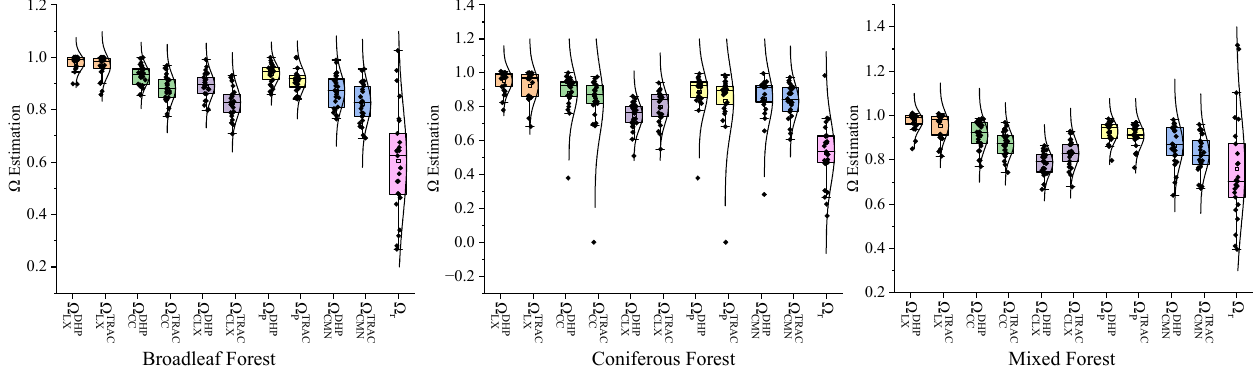
Figure 5. A comparison of CI estimation values using various methods in different forest types. ( Note: the black curve on the right indicates that the data are normally distributed.).